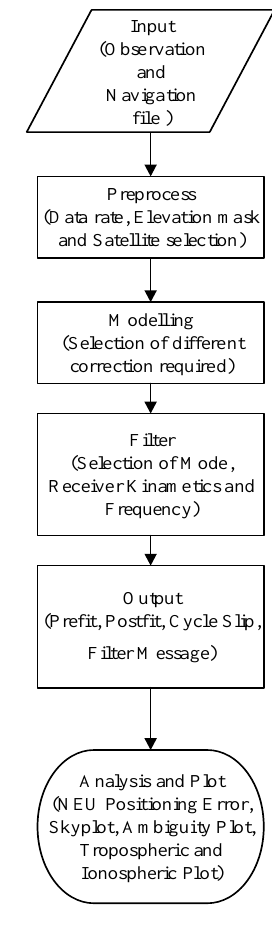
Figure 1: PPP processing using gLAB software